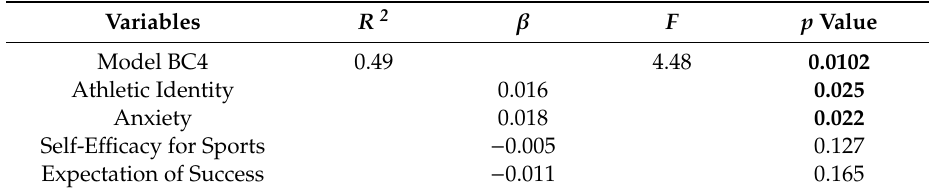
Table 4. Regression analysis predicting sport results among boccia players in